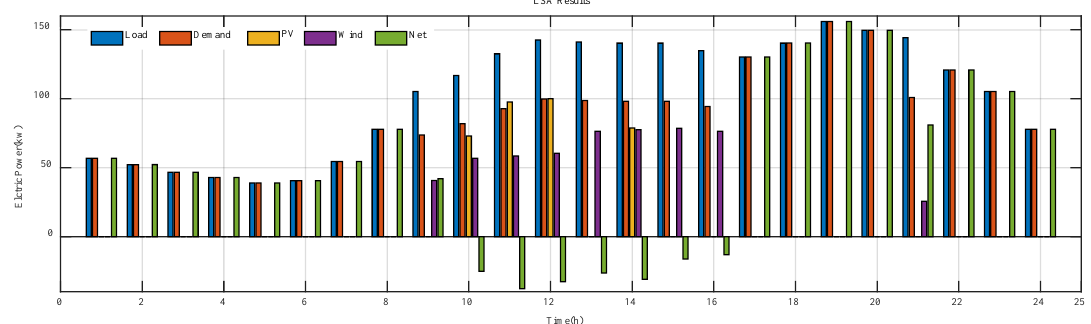
Figure 15. The power produced by energy generation sources (EGs) and the exchanged power with the upstream network in the third scenario (S3).